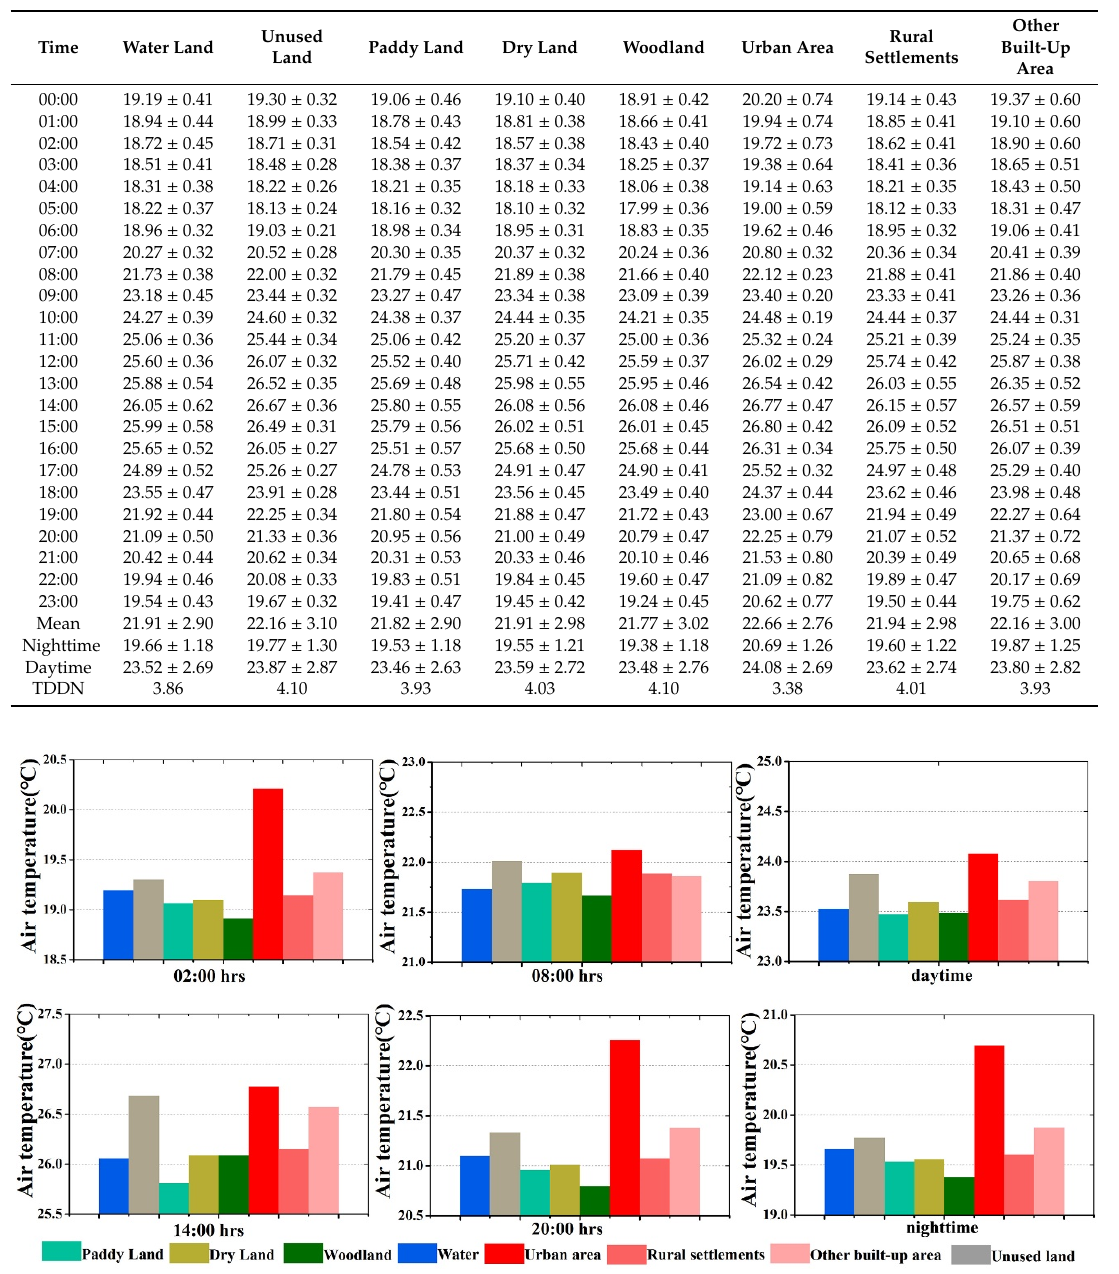
Table 6. Temperature at di ff erent times for di ff erent land use types ( ◦ C). The highest and lowest temperatures are highlighted with dark and light gray shadows, respectively.